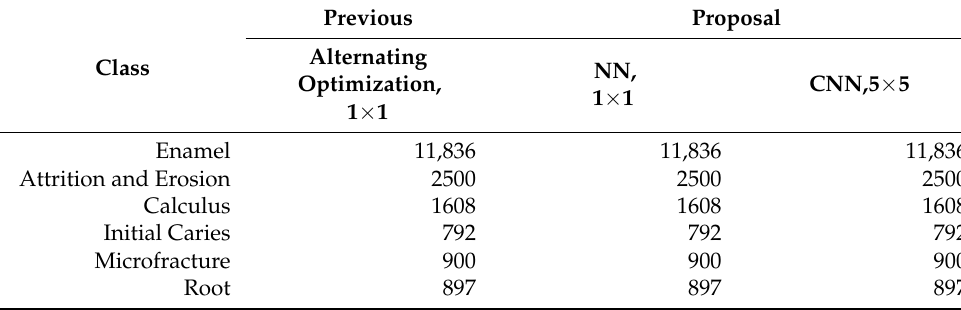
Table 5. The sample size for each class in the one-vs-rest classification.